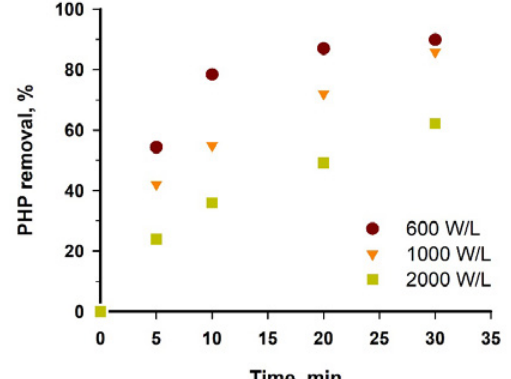
Fig. 7. PHP removal efficiency of the HSEF using different amount of 0.1Fe-ZSM-5 nanocatalyst. Reaction conditions: pH=7, applied current of 100mA, ultrasonic power of 600 WL -1 .